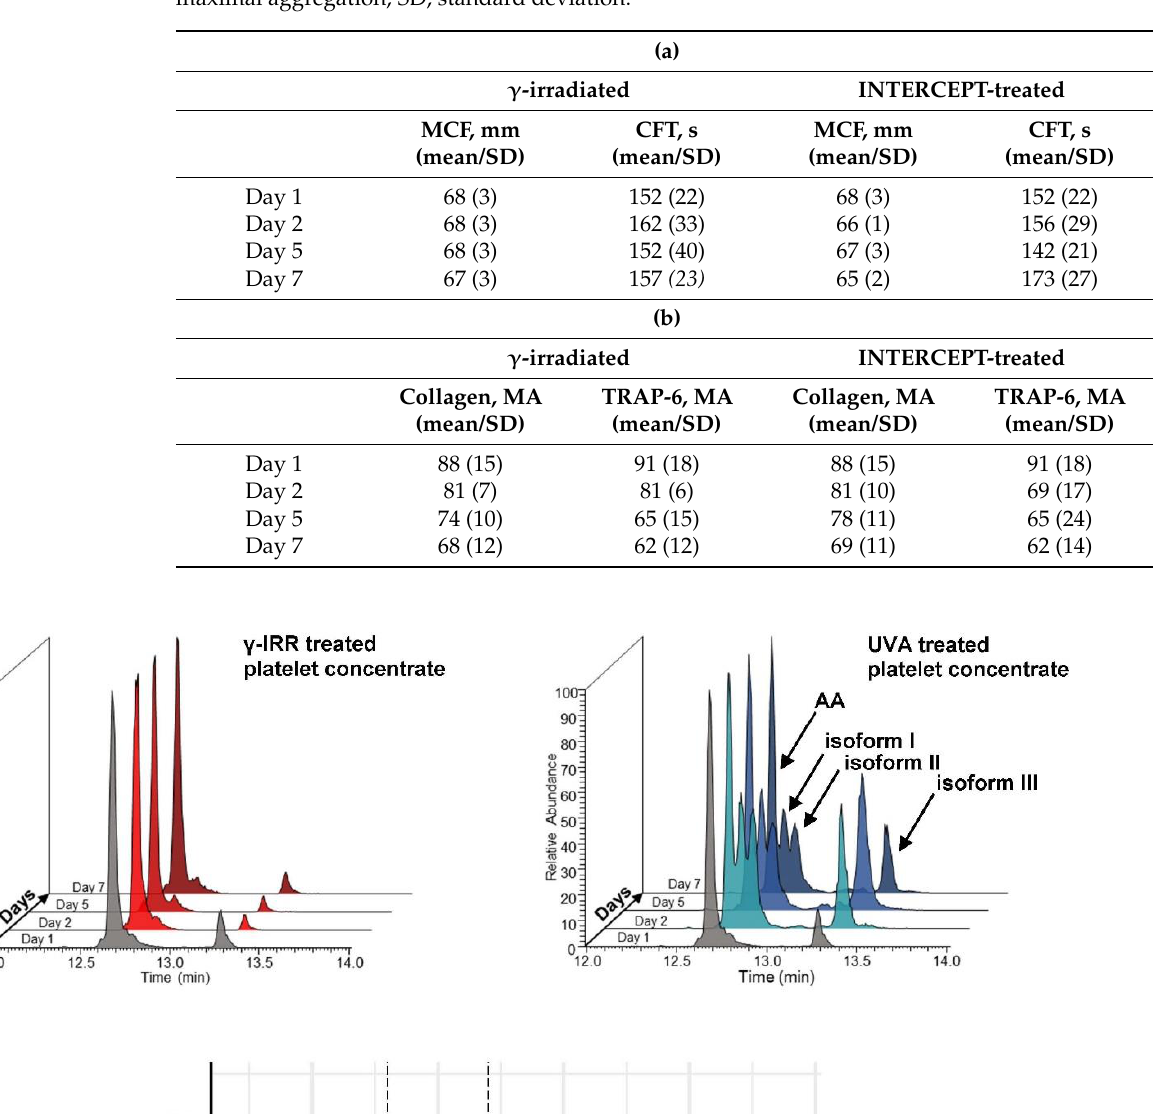
Table 1. ( a ): ROTEM data of γ -irradiated and INTERCEPT-treated platelet units. MCF, maximal clot firmness (millimeters); CFT, clot formation time (seconds); SD, standard deviation. ( b ): Aggregometry results after collagen and TRAP-6 enhancement. TRAP-6, thrombin receptor agonist peptide 6; MA, maximal aggregation; SD, standard deviation.